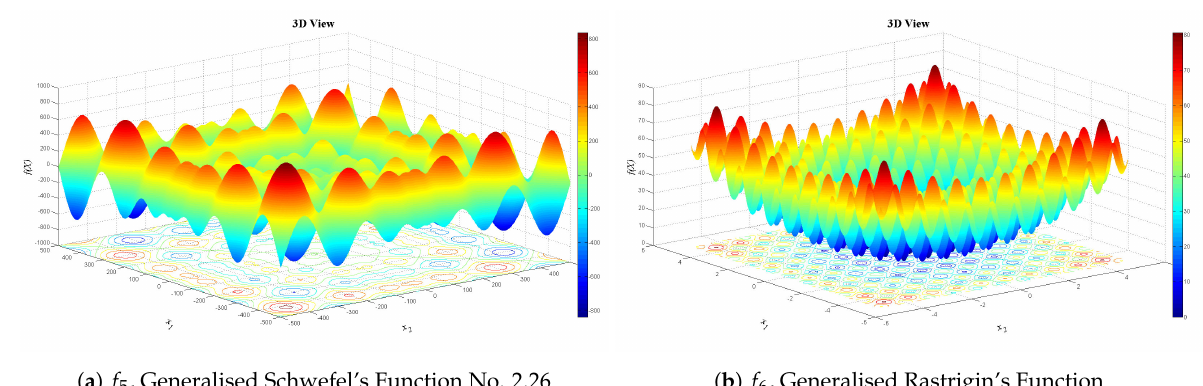
Figure 6. Multimodal benchmark mathematical functions f 5 and f 6 in a 3D view.